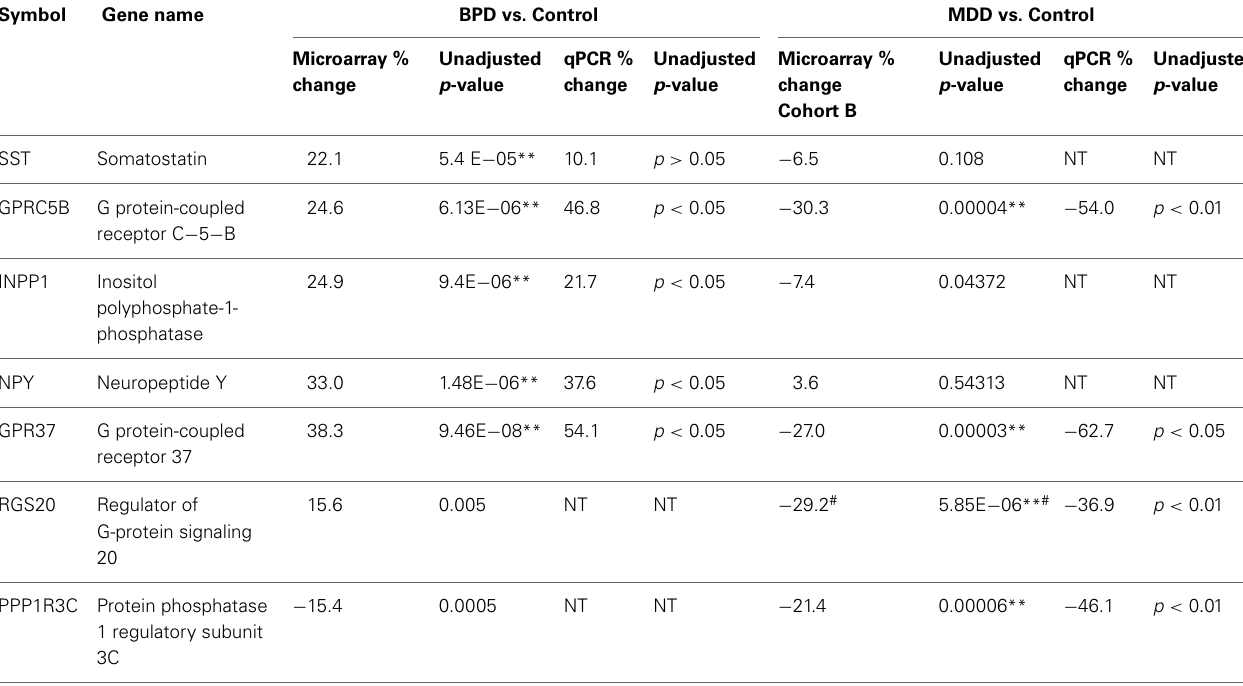
Table 3 | Quantitative PCR data summary of anterior cingulate cortex (ACC) genes in BPD or MDD that showed altered expression compared to the control group.